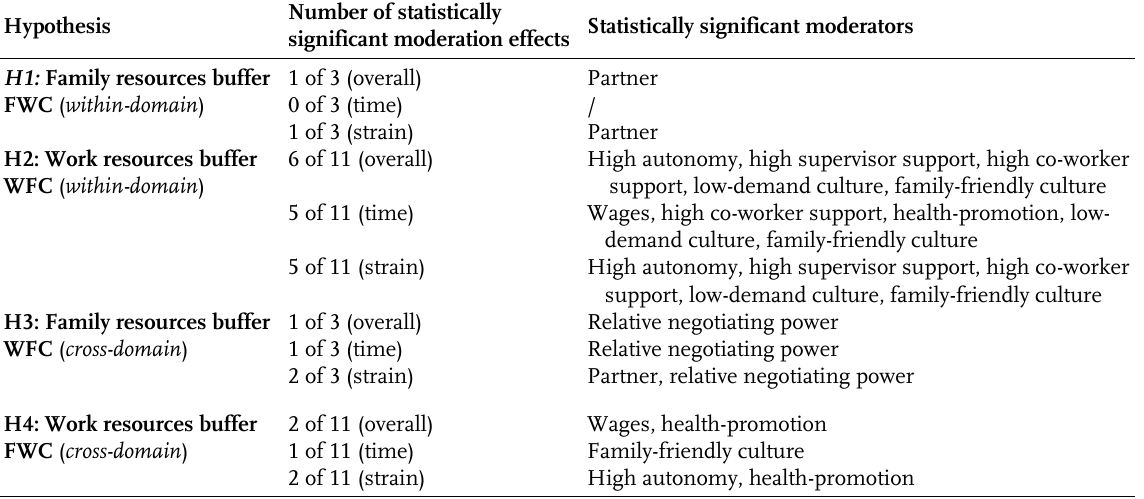
Table 3 : Overview of within-domain and cross-domain buffering of work-to-family and